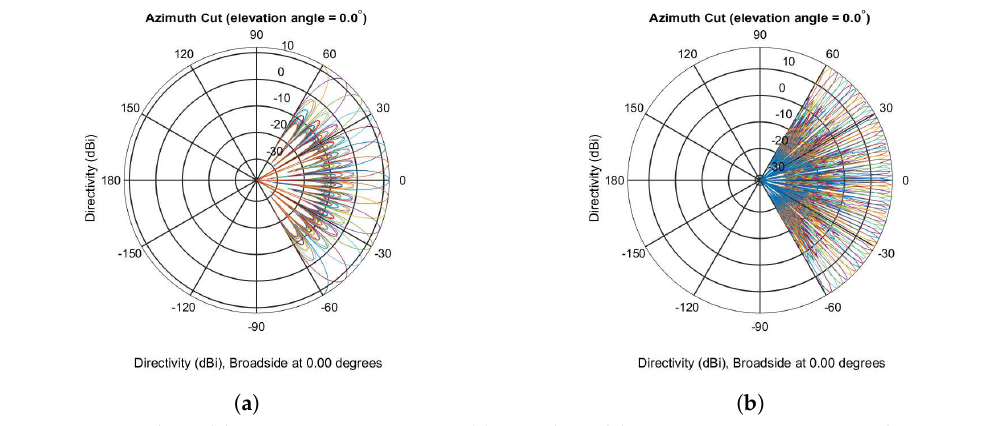
Figure 4. DFT-based beams in a 120 sector. ( a ) DFT-based beams in a 120 sector with N t = 16; ( b ) DFT-based beams in a 120 sector with N t =